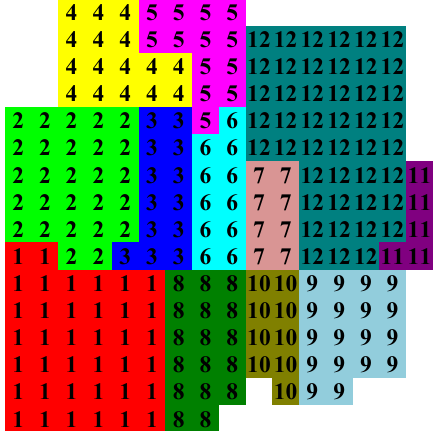
Fig. 13. The best solution obtain by genetic algorithm of Sadrzadeh (2012) for Problem